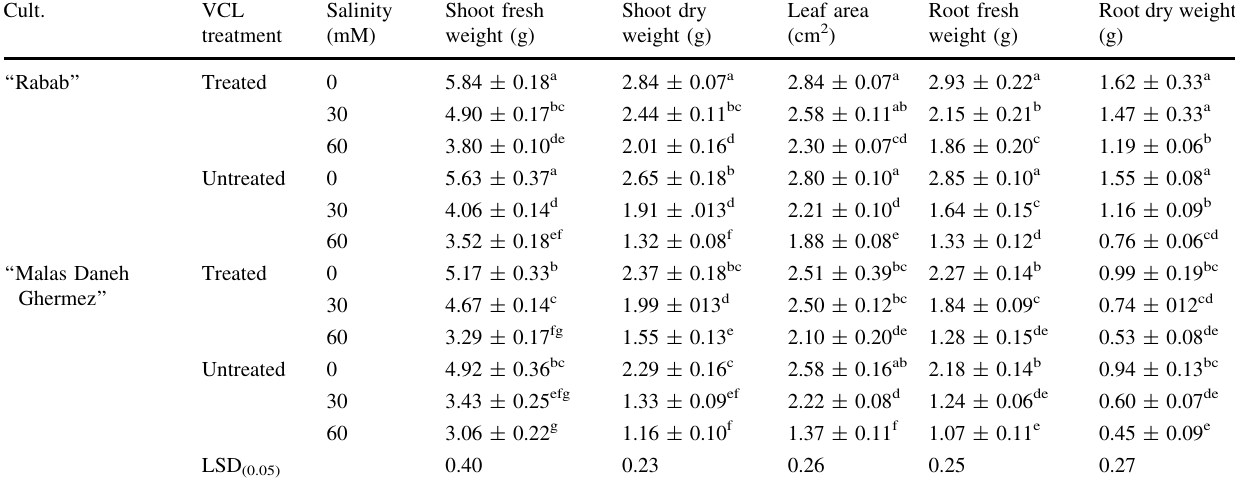
Table 2 Effects of VCL treatments on shoot fresh and dry weight, root, fresh and dry weight and leaf area of pomegranate seedlings under NaCl-induced salt stress